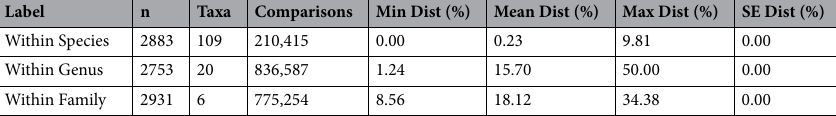
Table 3. Kimura 2 Parameter sequence divergence between barcode sequences at the species, genus and family